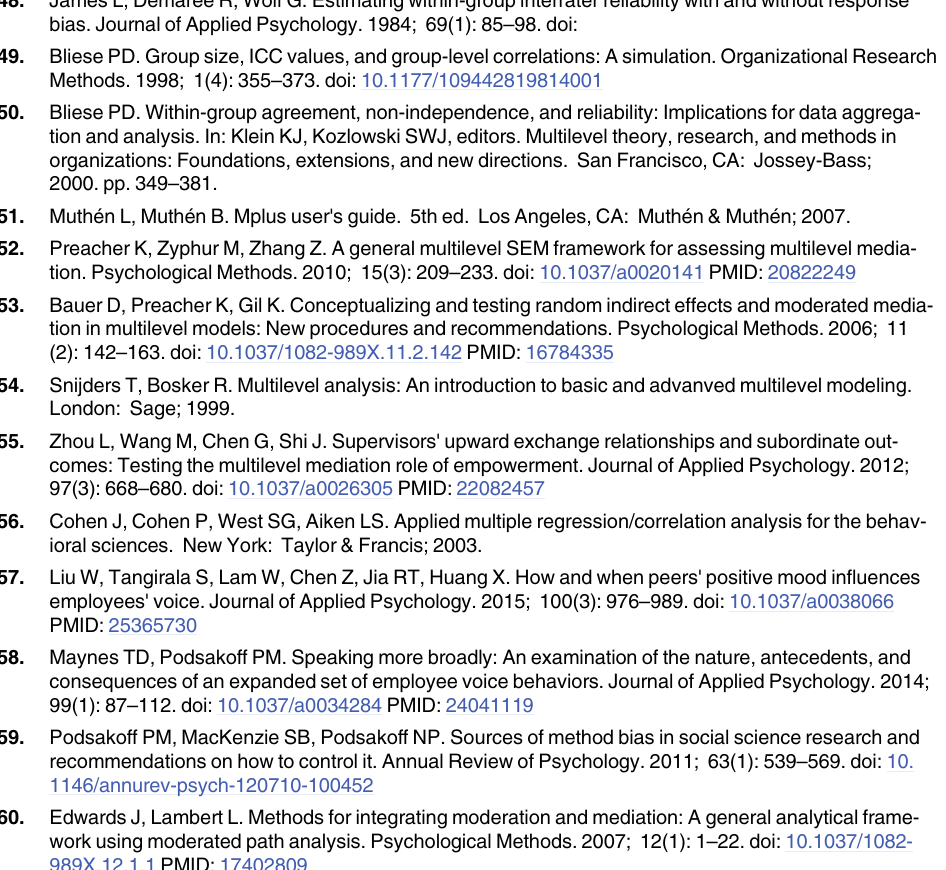
PLOS ONE | DOI:10.1371/journal.pone.0132123 July 6,